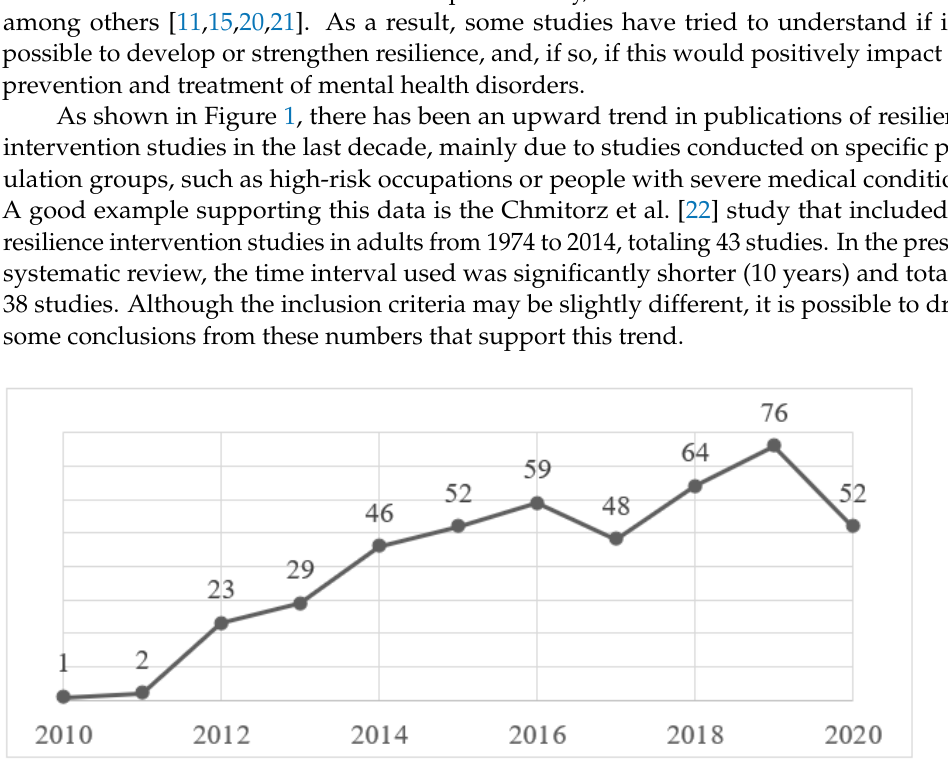
Figure 1. Timeline results of resilience intervention publications by year (2010–2020). Adapted from PubMed.